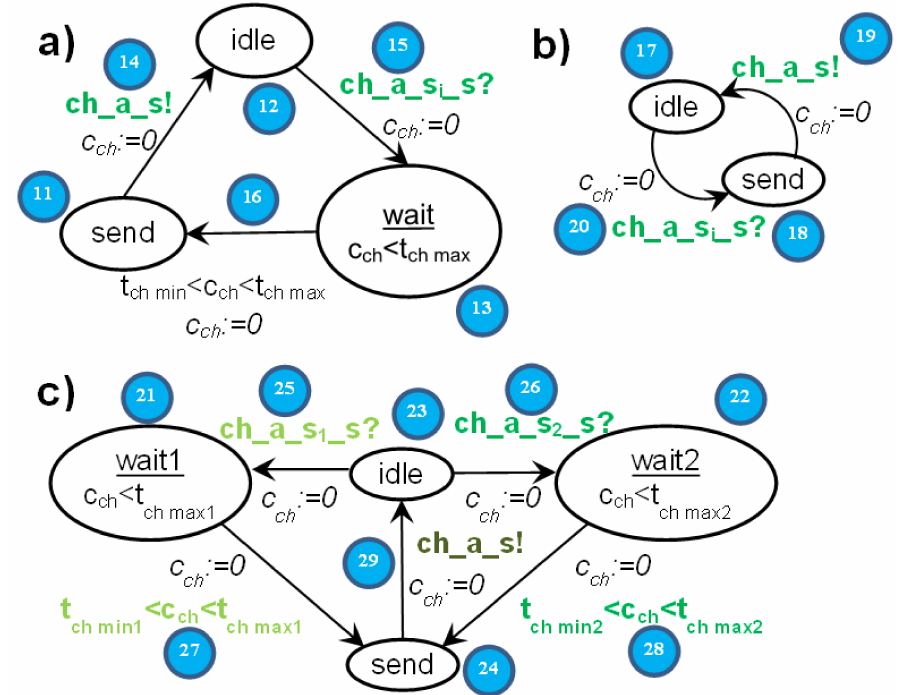
Figure 5. Implementation of communication between nodes in the context of the agent a (asyn- chronous channel): ( a ) basic asynchronous channel for messages directed to the node s; ( b ) the channel for sending messages from the node s to itself, or other 0-time channels; ( c ) passing messages from multiple nodes (two in this case) to the node s.